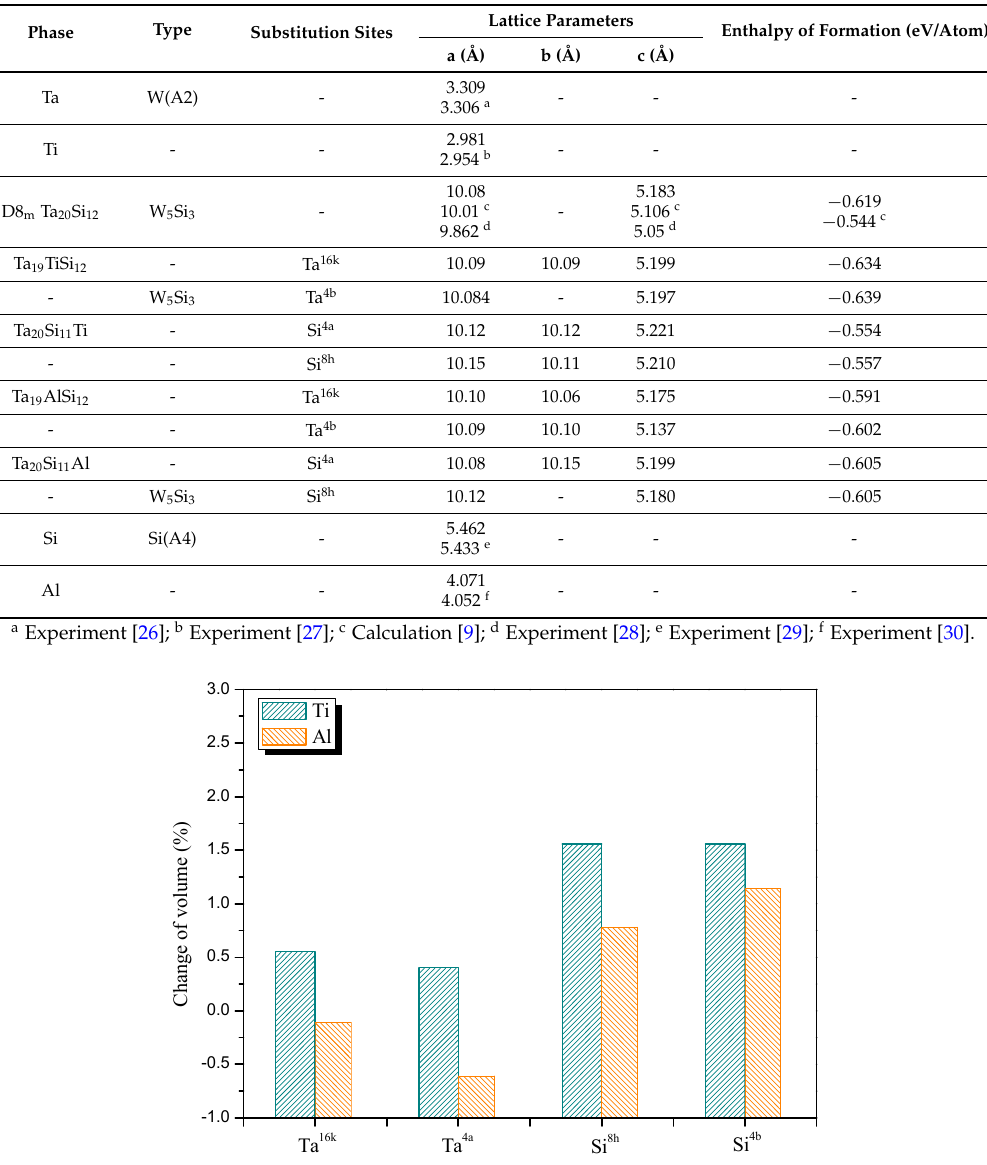
Table 1. Calculated lattice constants and enthalpies of formation for D8 m ‐ structured Ta 20 Si 12 and alloyed D8 m Ta 20 Si 12 .